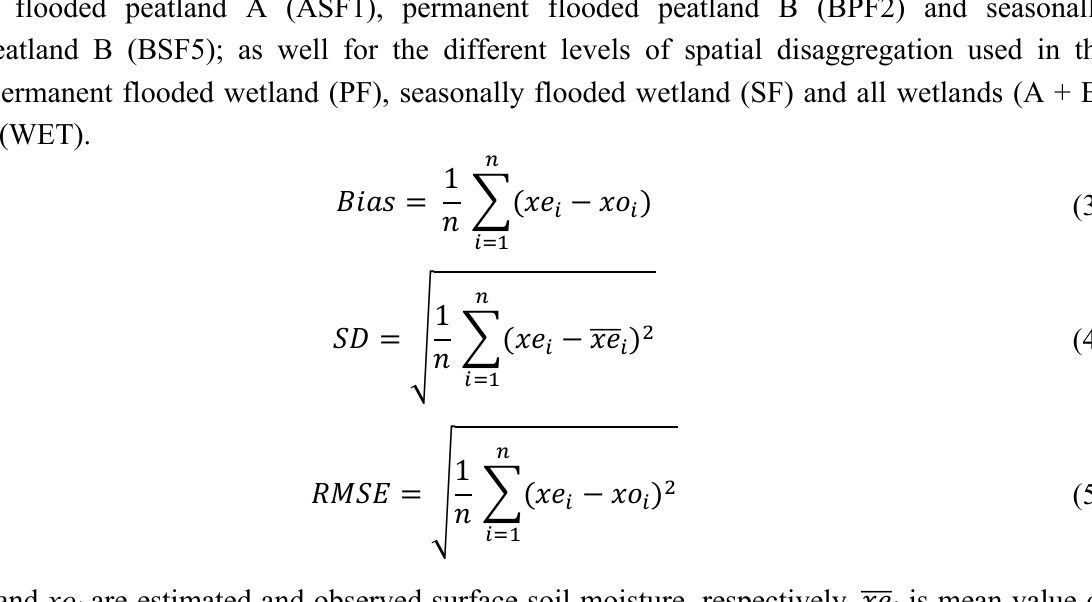
cross-validation method (Figure 7), for each spatial unit: permanent flooded peatland A (APF1), seasonally flooded peatland A (ASF1), permanent flooded peatland B (BPF2) and seasonally